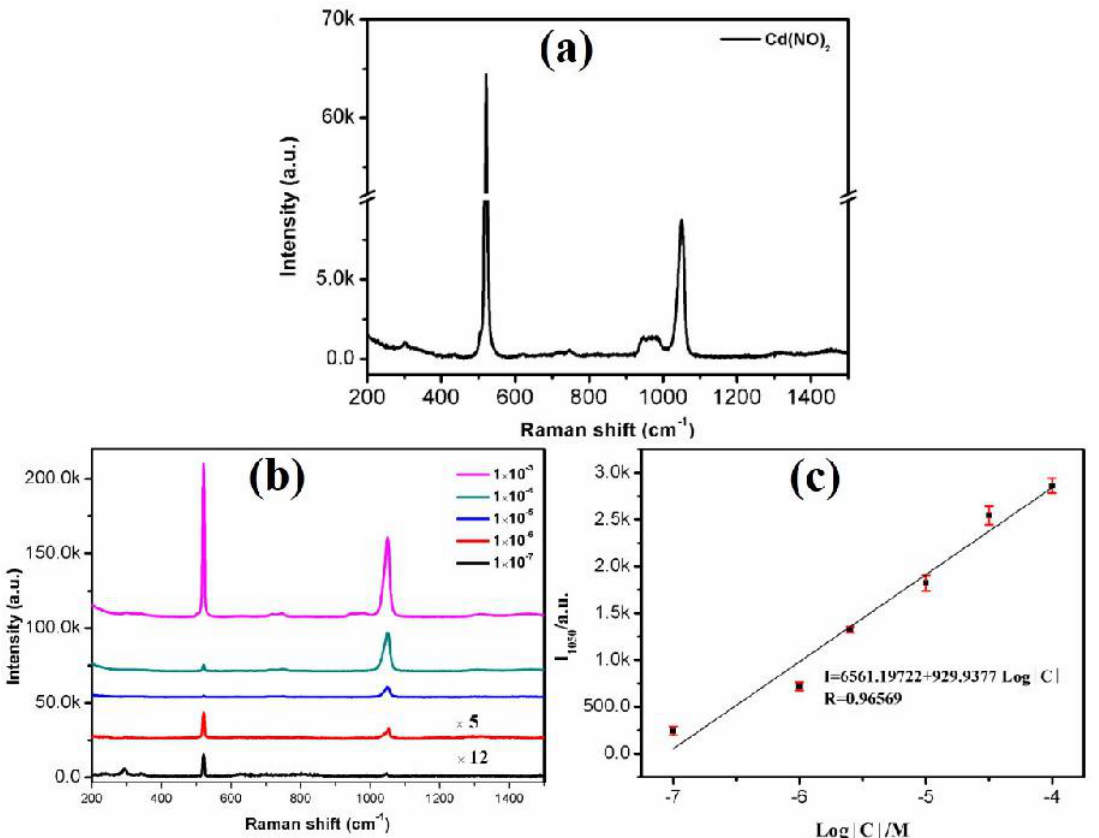
Figure 6. SERS spectra of cadmium nitrate at di ff erent concentrations. ( a ) cadmium nitrate solution; ( b ) at concentrations of 1.0 × 10 − 3 –1.0 × 10 − 7 M on the Ag@CuO FM substrates; ( c ) linear calibration plot between SERS intensity and